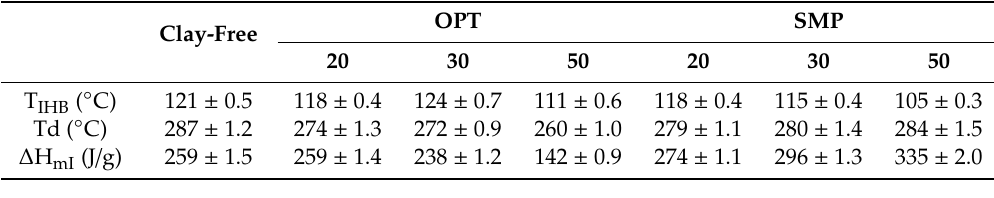
Figure 2. Differential scanning calorimetry (DSC) thermograms of Clay-free, OPT20 and SMP20 samples.